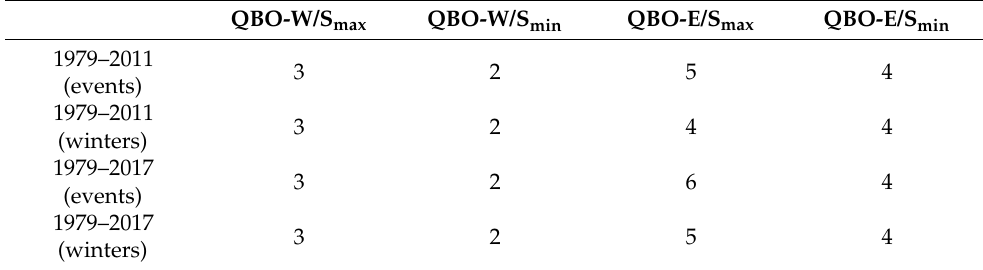
Table 2. Number of events and winters of sudden stratospheric warmings (major warmings) in the Northern Hemisphere during the four QBO/solar